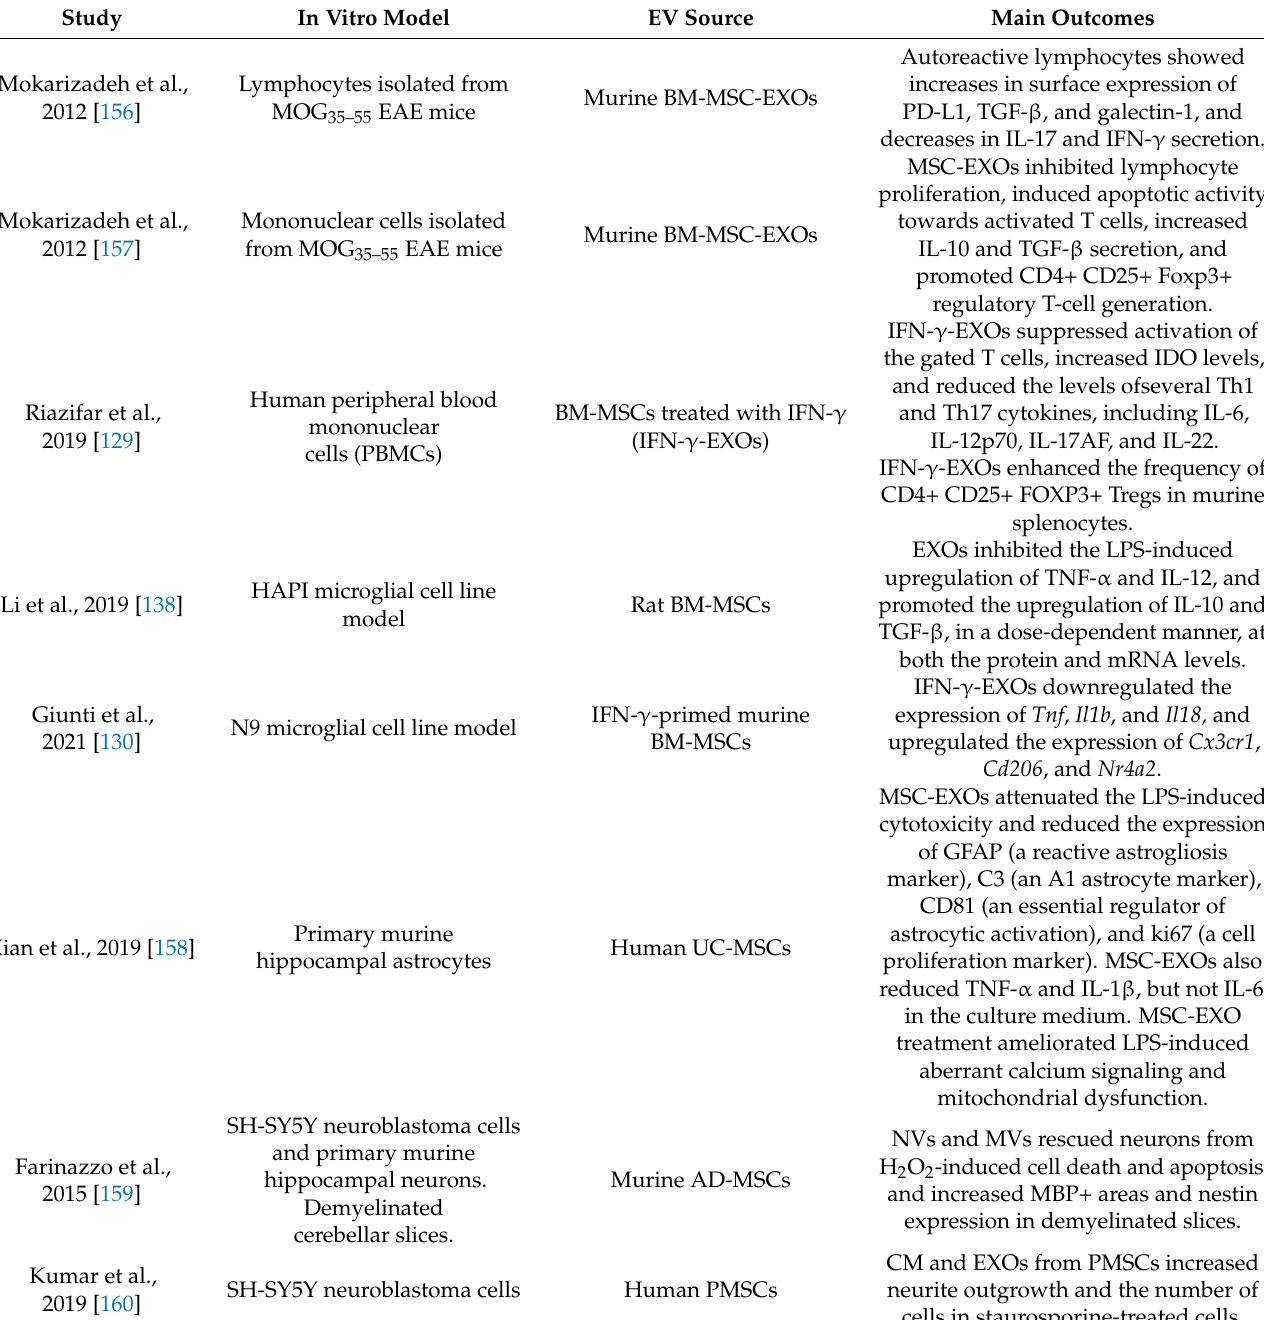
Table 2. MSC-EVs and in vitro molecular